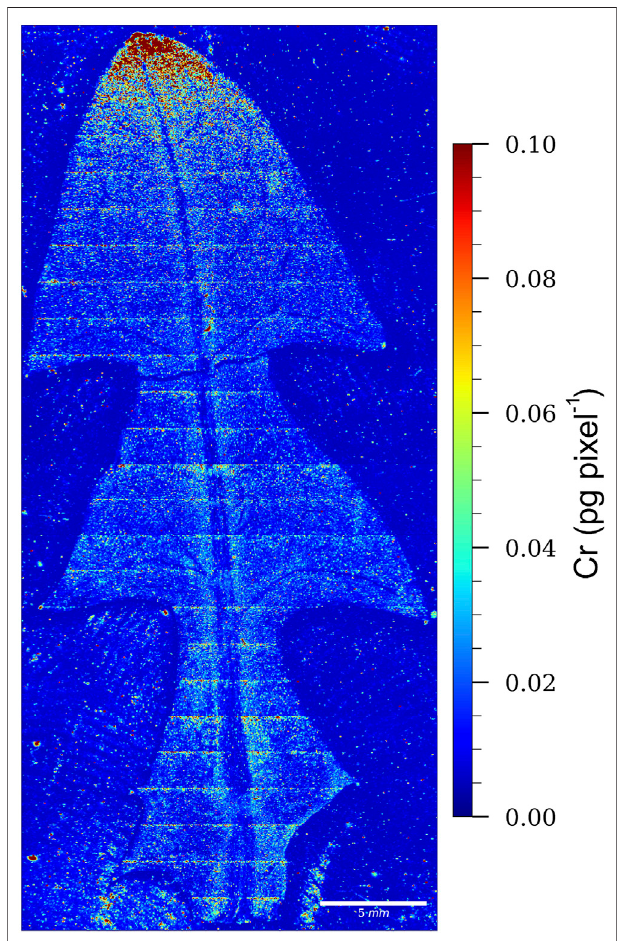
FIGURE 6 | LA-ICP-MS image of a dandelion leaf from Vranja Pe č , showing the relative distribution of Cr. The color scale (red to blue; highest to lowest) denotes the Cr